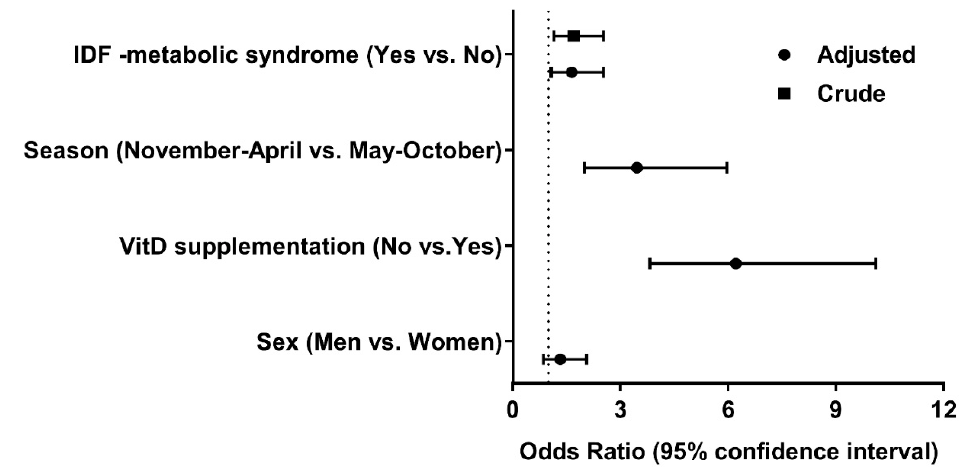
Figure 2. Forest plot for the risk of low levels (less than 75 nmol/L) of Vitamin D. Adjusted odds ratios and their 95% confidence interval for each factor. IDF: International Diabetes Federation, VitD: vitamin D.